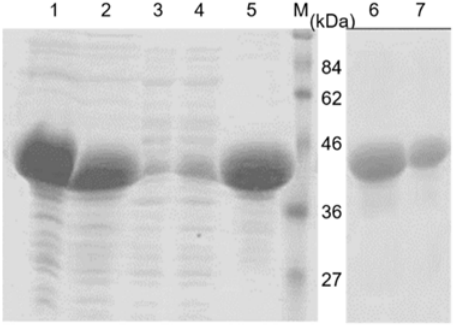
Figure 3. Separation of the purified recombinant SCMVCp protein using SDS-PAGE. The insoluble protein was extracted from the pellet, applied and fractionated into an affinity Ni-NTA resin. The fractioned protein was then separated by SDS-PAGE (10 % acrylamide) and stained with Coomasie Brilliant Blue. Lanes 1, 2, 3, 4, and 5 are the total-insoluble, re-loaded flow through, unbound, 20 mM-washed and 250 Mm-eluted imidazole protein fractions, respectively. Lane 6 and 7 show the protein after electroelution and dialyzed against PBS. M is a protein marker.